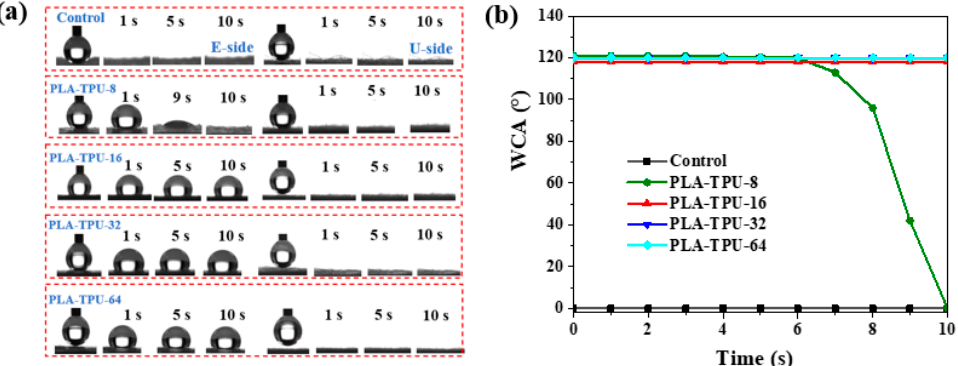
Figure 5. WCA of micro-/nano-composite membranes as related to different TPU layer thickness, ( a ) The dynamic photographs, and ( b ) WCA, water dropped onto TPU side.